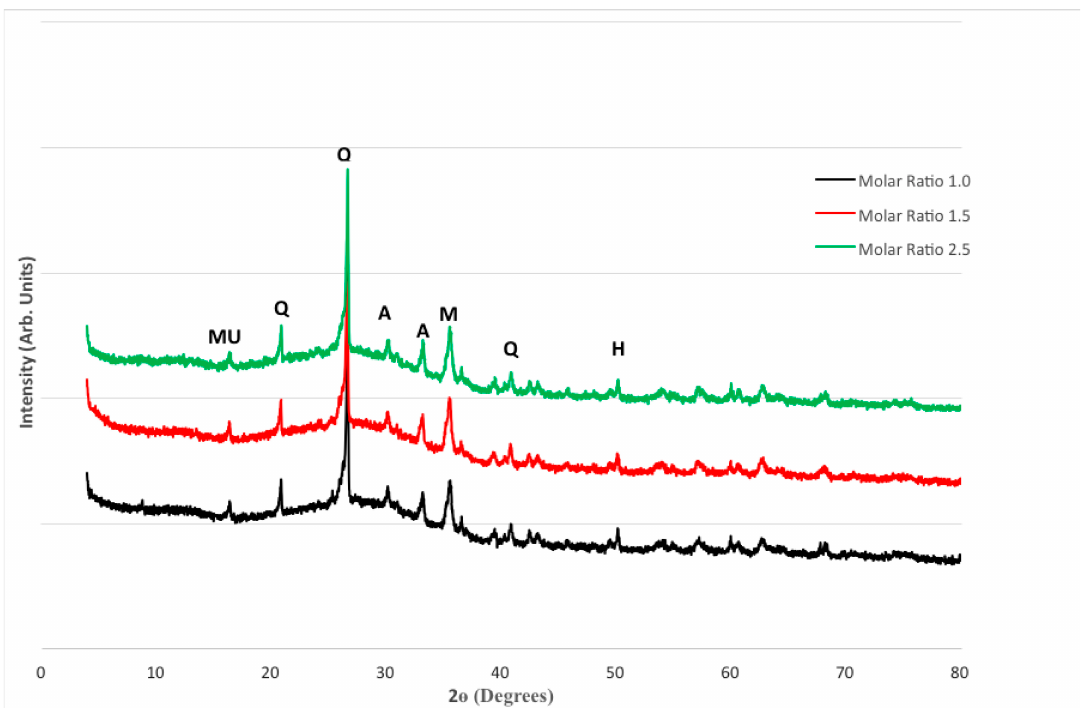
Figure 9. XRD Patterns for FA and MK-based geopolymers.